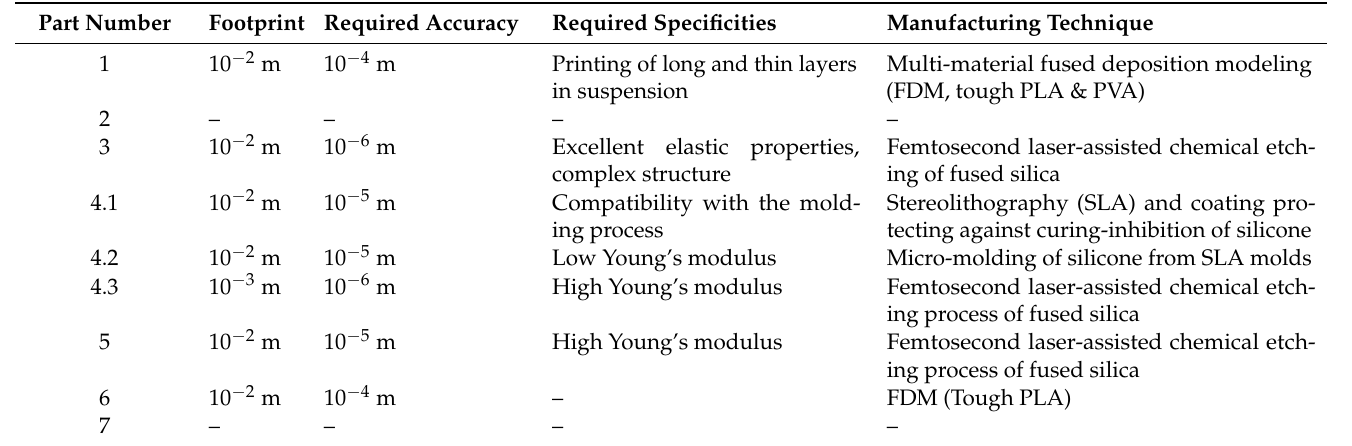
Table 1. Overview of the manufactured parts and their respective manufacturing techniques. The choice was based on the footprint of the parts (i.e., their overall size), the accuracy needed for certain features, and certain mechanical specificities, such as superior elastic properties.